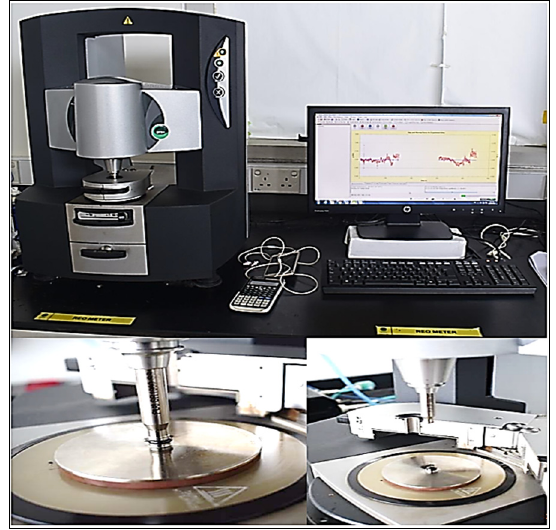
Figure 8. Kinexus DSR.